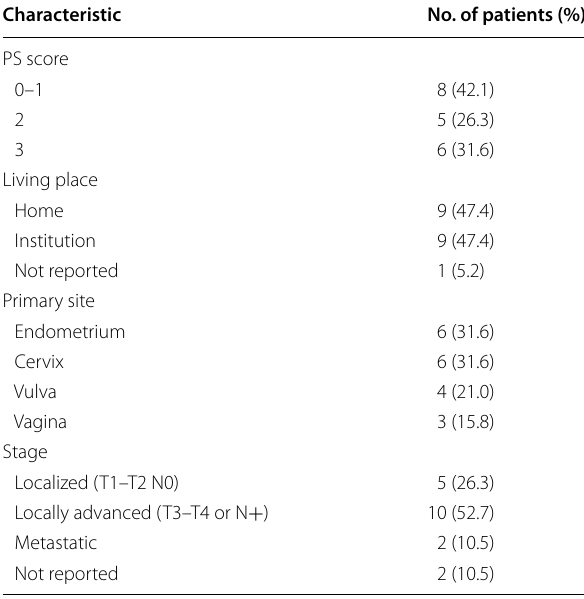
Table 1 Characteristics of 19 nonagenarian patients with gynecologic